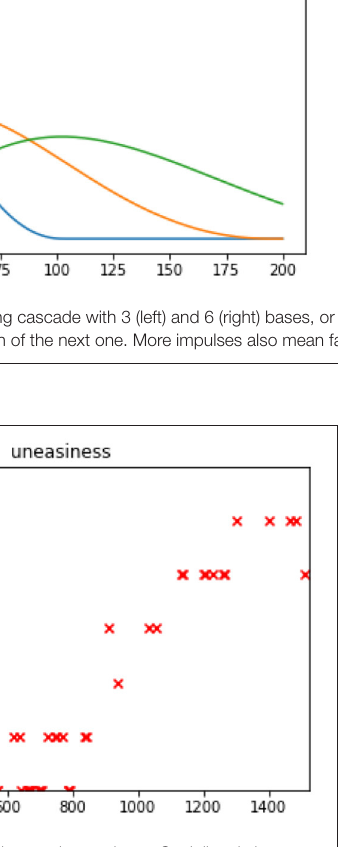
FIGURE 3 | An event cascade for the word uneasiness . Sociolinguistic groups on the y-axis, chronologically ordered series of letters on the